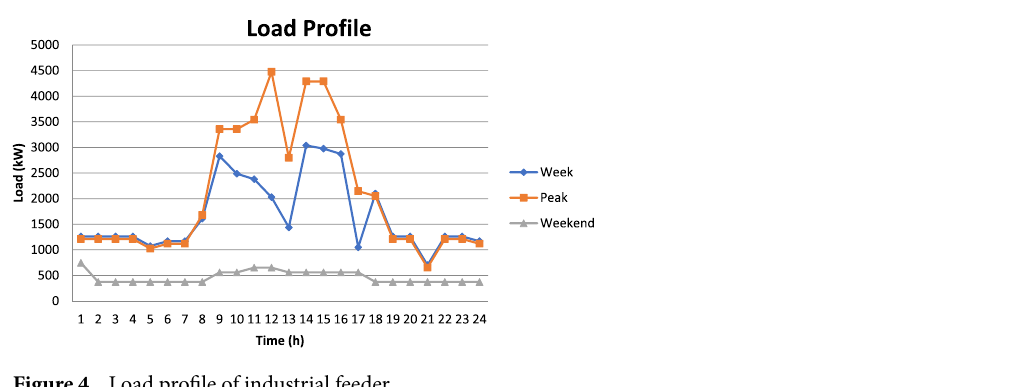
Figure 4. Load profile of industrial